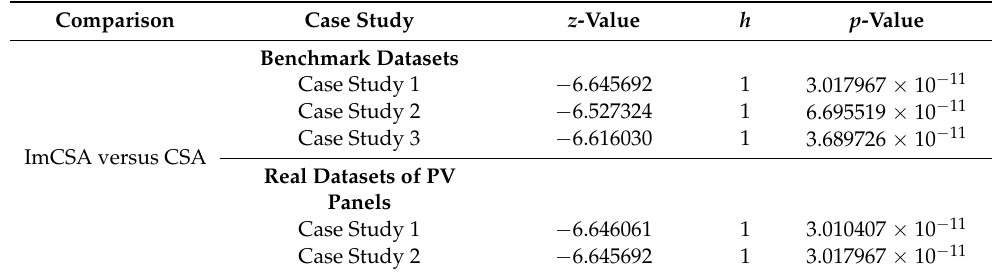
Table 17. Results of the Wilcoxon rank-sum test on the data in Tables 1, 4, 7, 10 and 13.